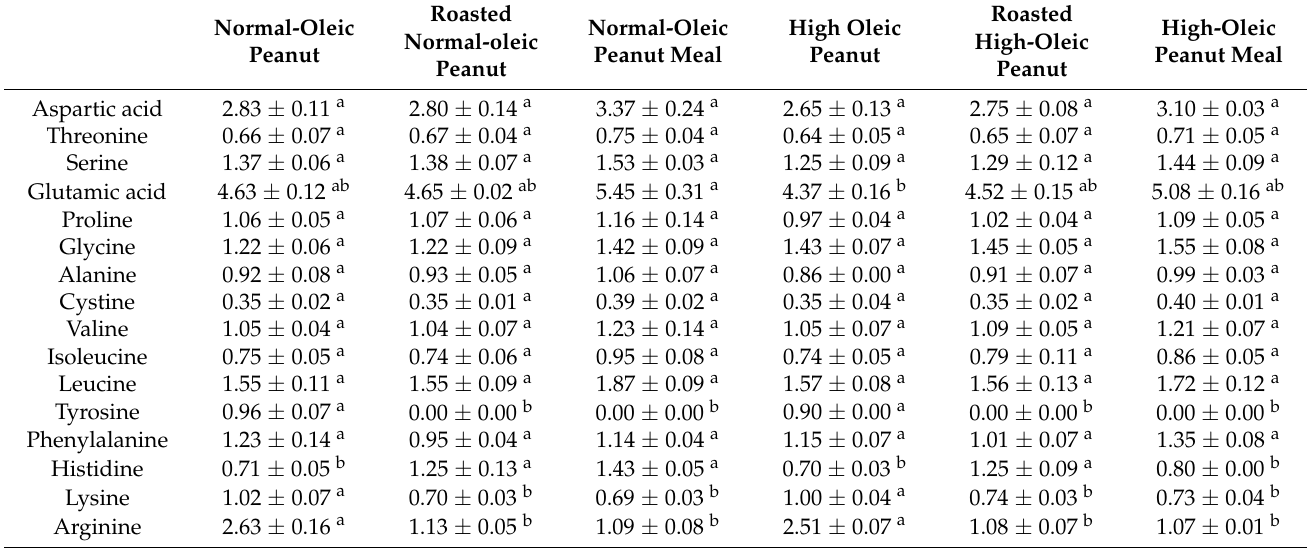
Volume in a row with different superscripts were significantly different ( p < 0.5). Table 5. Sugars profile of normal- and high-oleic peanut oil processing samples (g/kg). Roasted Normal-Oleic Normal-Oleic Normal-Oleic Peanut Peanut Meal Peanut